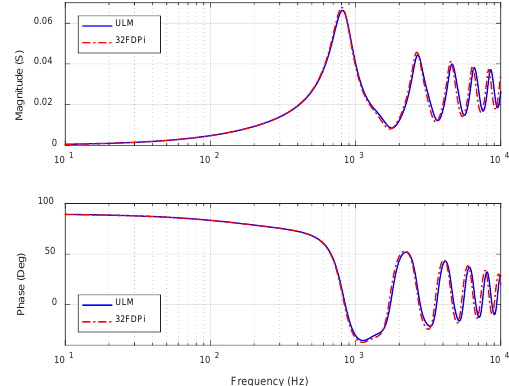
Figure 7. Cable admittance comparison for Case Study #1.